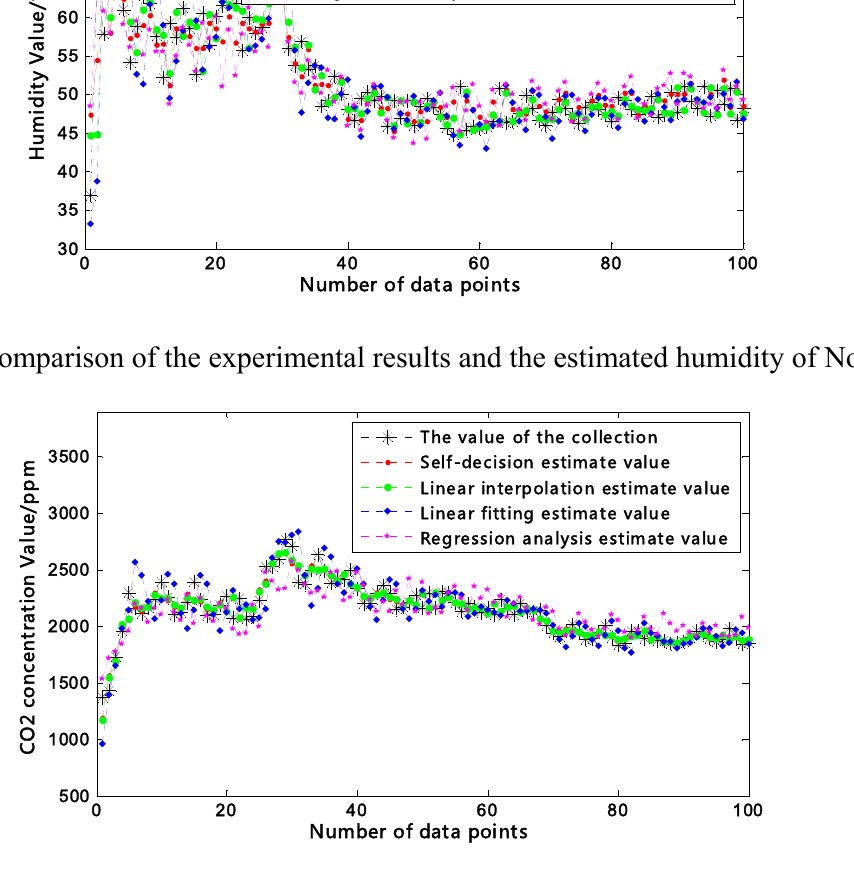
Figure 9. Comparison of the experimental results and the estimated concentration of CO 2 of Node